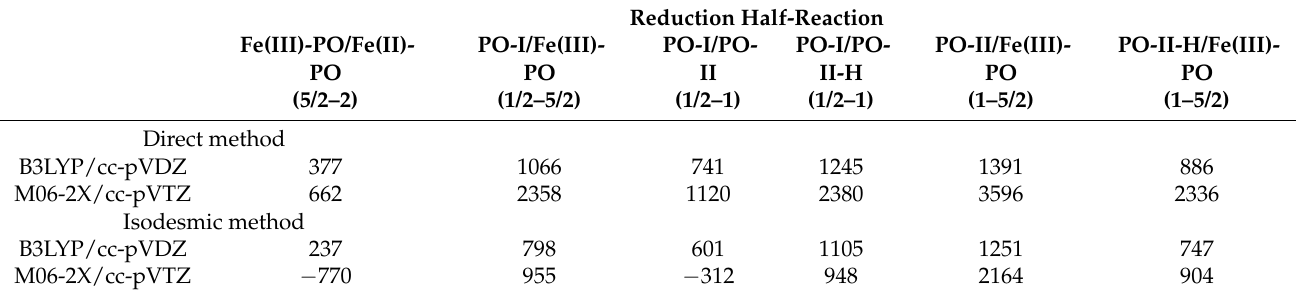
Table 3. Standard reduction potential ( E ◦ ) values in mV relative to SHE calculated with direct and isodesmic methods, at B3LYP/cc-pVDZ and M06-2X/cc-pVTZ computational levels ( T = 298.15 K). The most favourable spin states were employed (as specified in